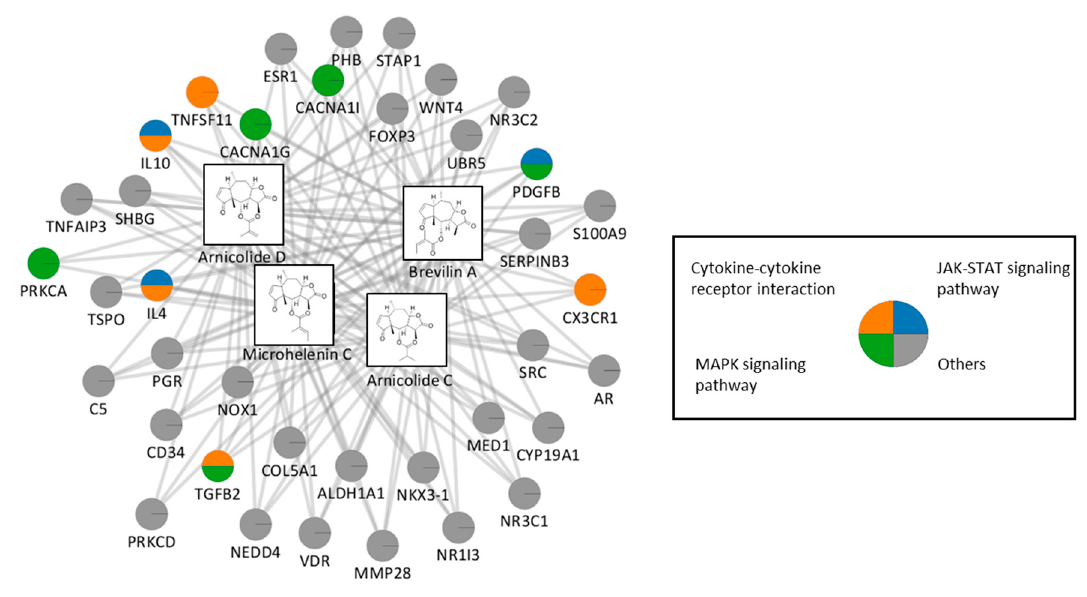
Figure 7. Compound-target network of CMX. Rectangles and circles represent the compounds and targets, respectively. Lines between compounds and targets indicate the interactions between them.